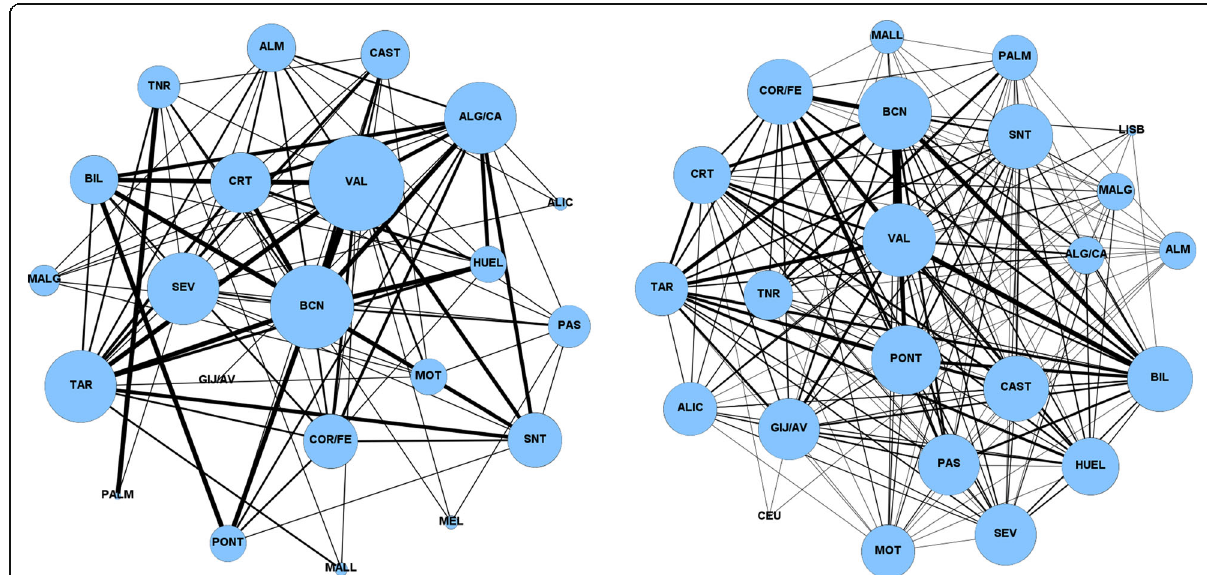
Fig. 7 Graphs representing the membership of pairs of ports to the same community for import flows in 2009 (left) and 2019 (right). The size of the nodes is proportional to their degree, and the thickness of the links is proportional to the number of communities shared by both